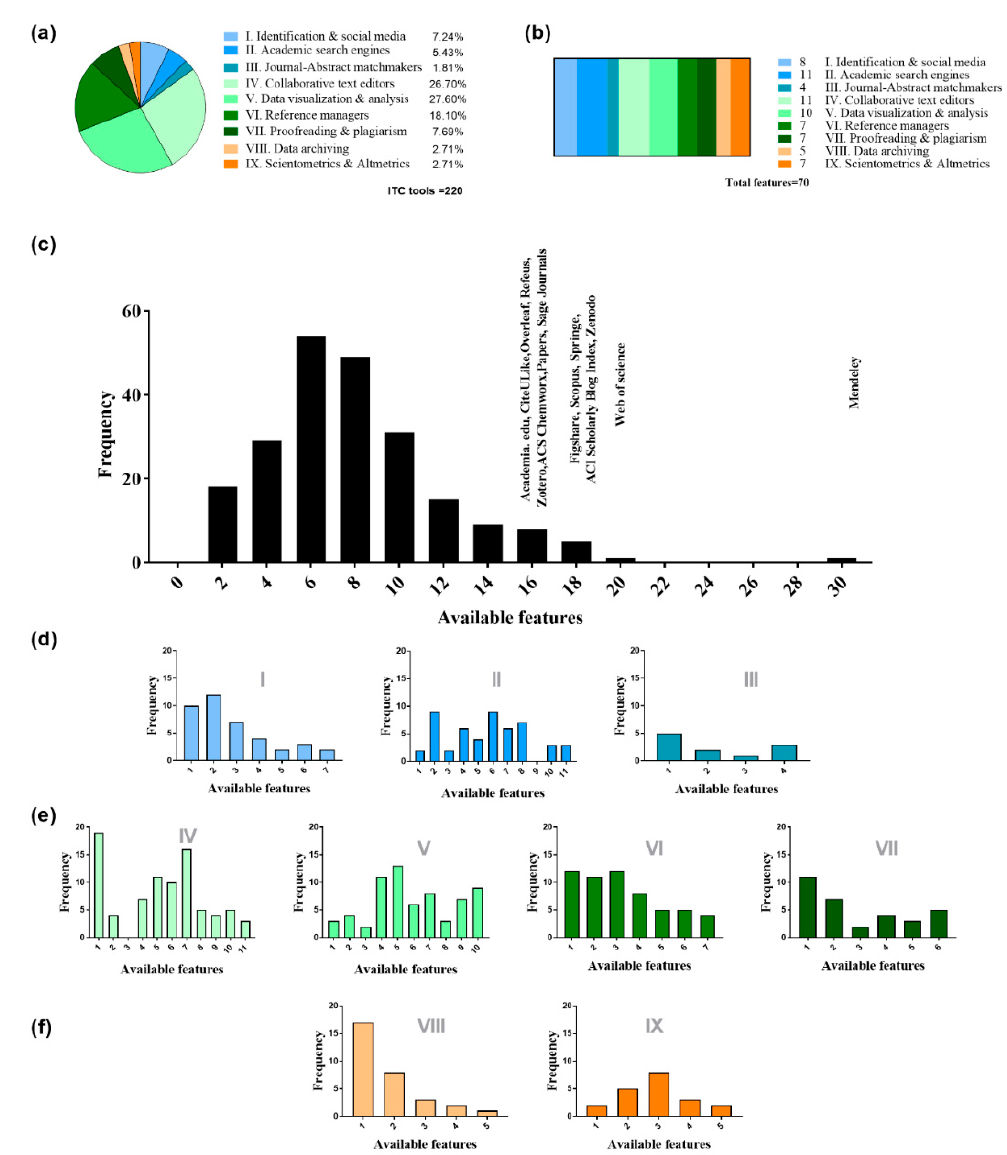
Figure 3. ITC tools analysis; ( a ) distribution of characterized tools by nominal category, ( b ) number of features analyzed by category; ( c ) frequency versus number of overall available features of ITC Tools, ( d ) frequency versus number of features of available features of pre-submission ITC tools (categories I, II and III); ( e ) frequency versus number of features of available features of during submission ITC tools (categories IV, V, VI and VII); and ( f ) frequency versus number of features of available features of post-submission ITC tools (categories VIII and IX). More information about the scoring with identification number (within brackets) in Supplementary File S2.